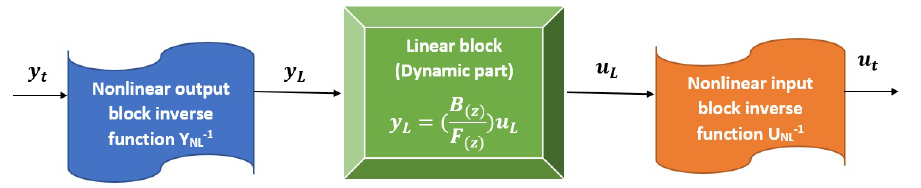
Figure 9. Reduced model (Hammerstein − Wiener) with inverse